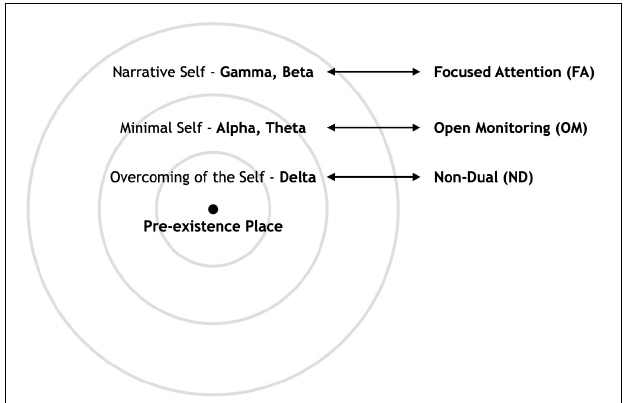
FIGURE 2 | The hierarchy of Selves in the Sphere Model of Consciousness corresponding to the hierarchy of meditation and their primary electrophysiological